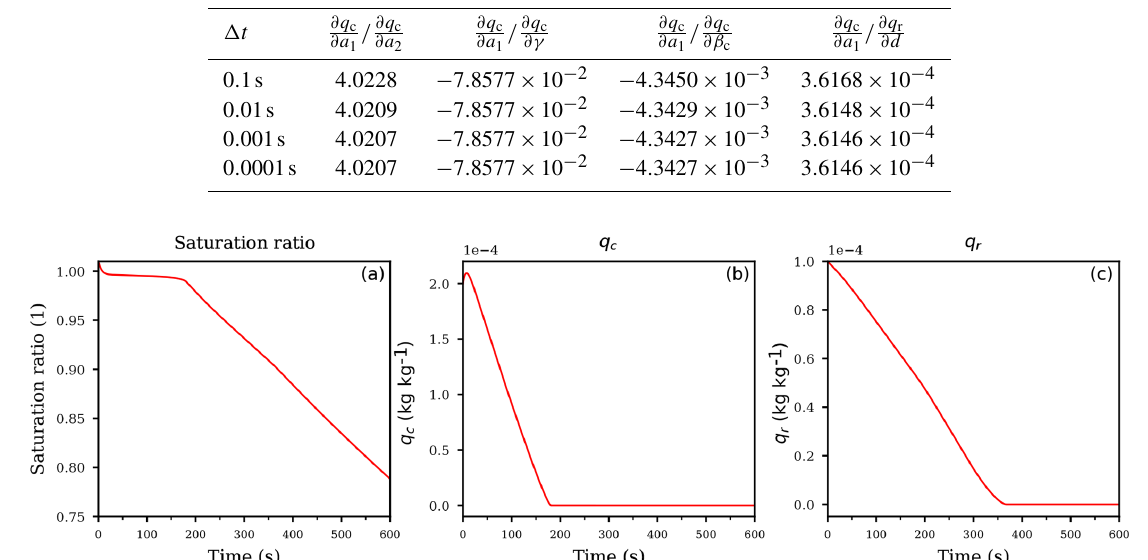
Table 2. Ratios of the derivatives of the mixing ratios with respect to different parameters at t = 1000s, computed for several time steps (cid:49)t . All numbers are taken from the computations of the first case of an ascending air parcel with no pre-existing cloud. The numbers are rounded to four digits.